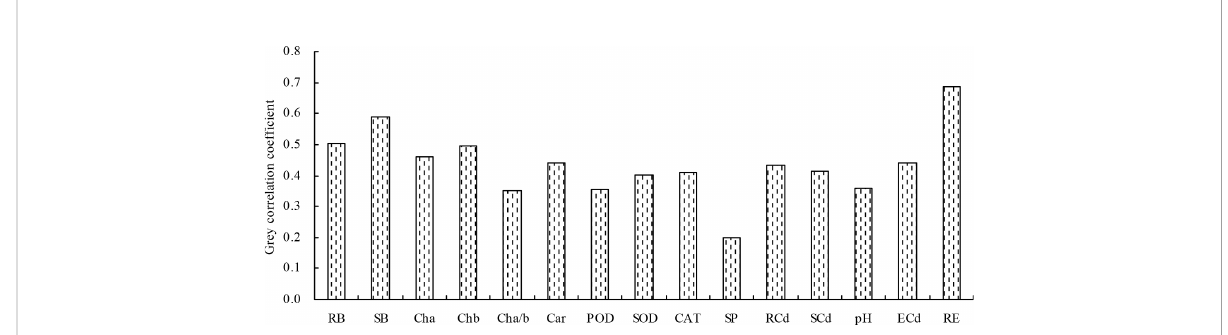
FIGURE 5 Grey correlation coef fi cients of the different indicators with the shoot Cd extraction. RB, root biomass; SB, shoot biomass; Cha, chlorophyll a content; Chb, chlorophyll b content; Cha/b, chlorophyll a / b ; Car, carotenoid content; POD, POD activity; SOD, SOD activity; CAT, CAT activity; SP, soluble protein content; RCd, root Cd content; SCd, shoot Cd content; pH, soil pH value; ECd, soil exchangeable Cd concentration; RE, root Cd